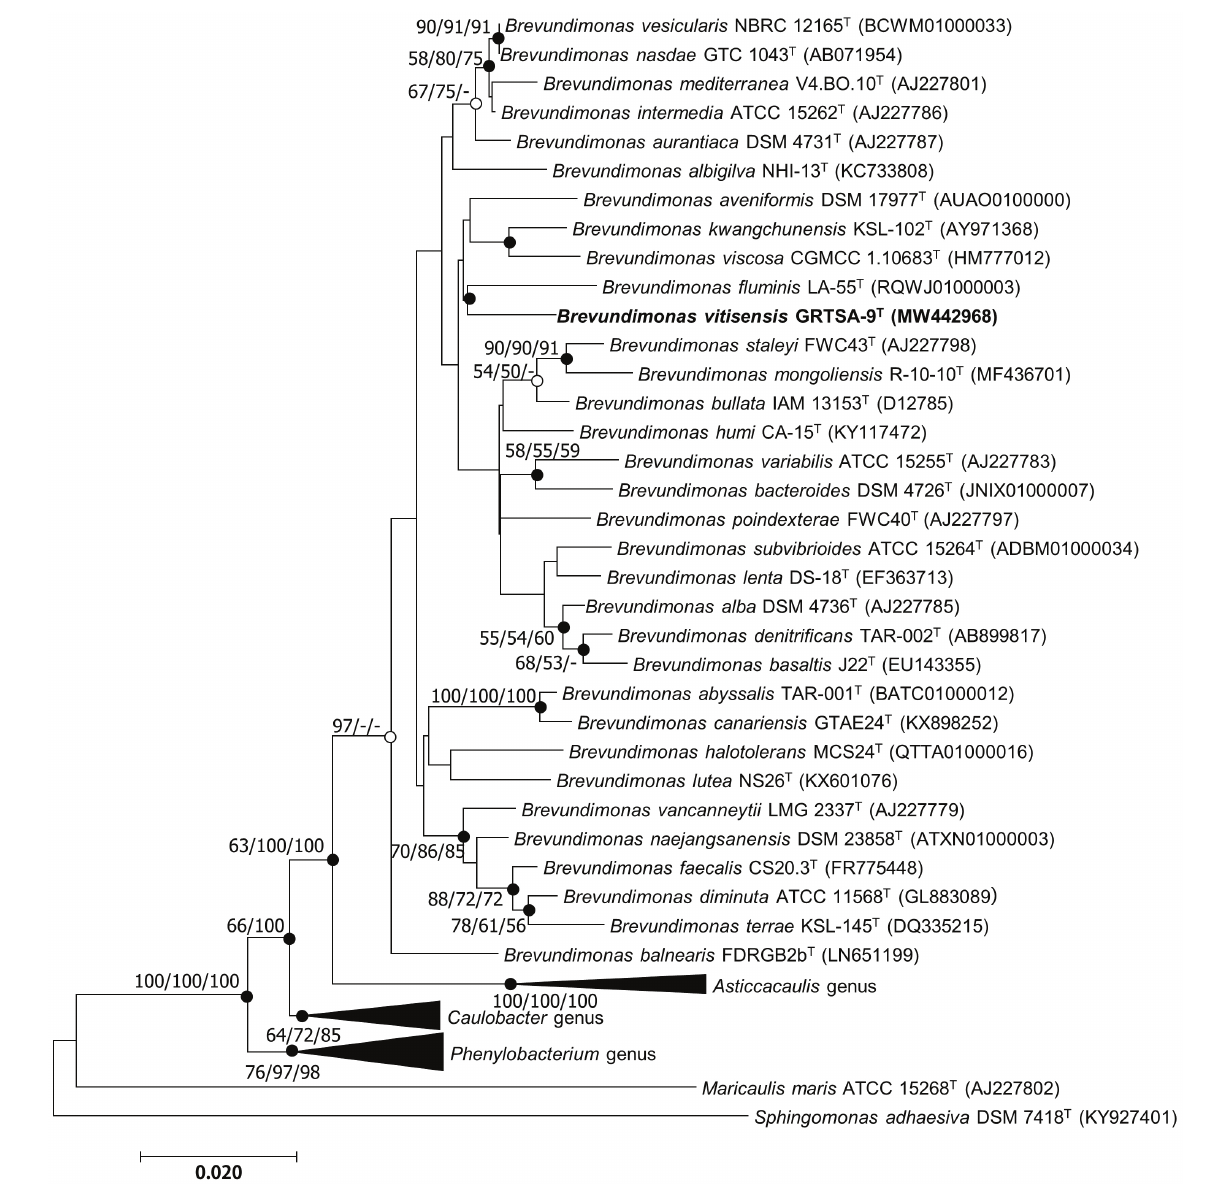
FIGURE 1 | Neighbor-joining (NJ) algorithm phylogenetic tree based on 16S rRNA genes of strain GR-TSA-9 T and the members of the family Caulobacteraceae . Bootstrap values (>70%) calculated using the NJ, maximum likelihood (ML), and minimum evolution (ME) algorithms are shown. Filled circles on the nodes indicate that the relationships were also recovered by ML and ME algorithms, whereas open circles indicate nodes recovered by either ML or ME algorithms. Scale bar: 0.020 substitutions per nucleotide